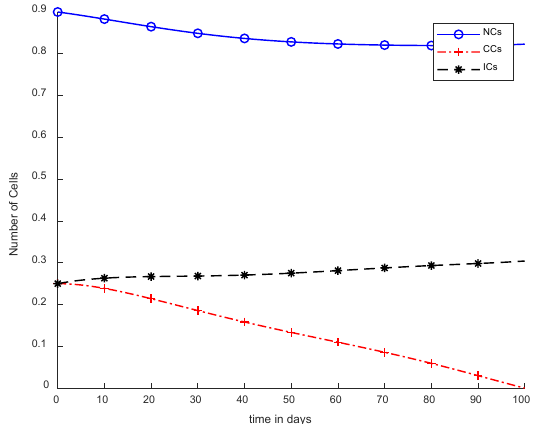
Figure 5. With chemotherapy at a constant dose and without controller.